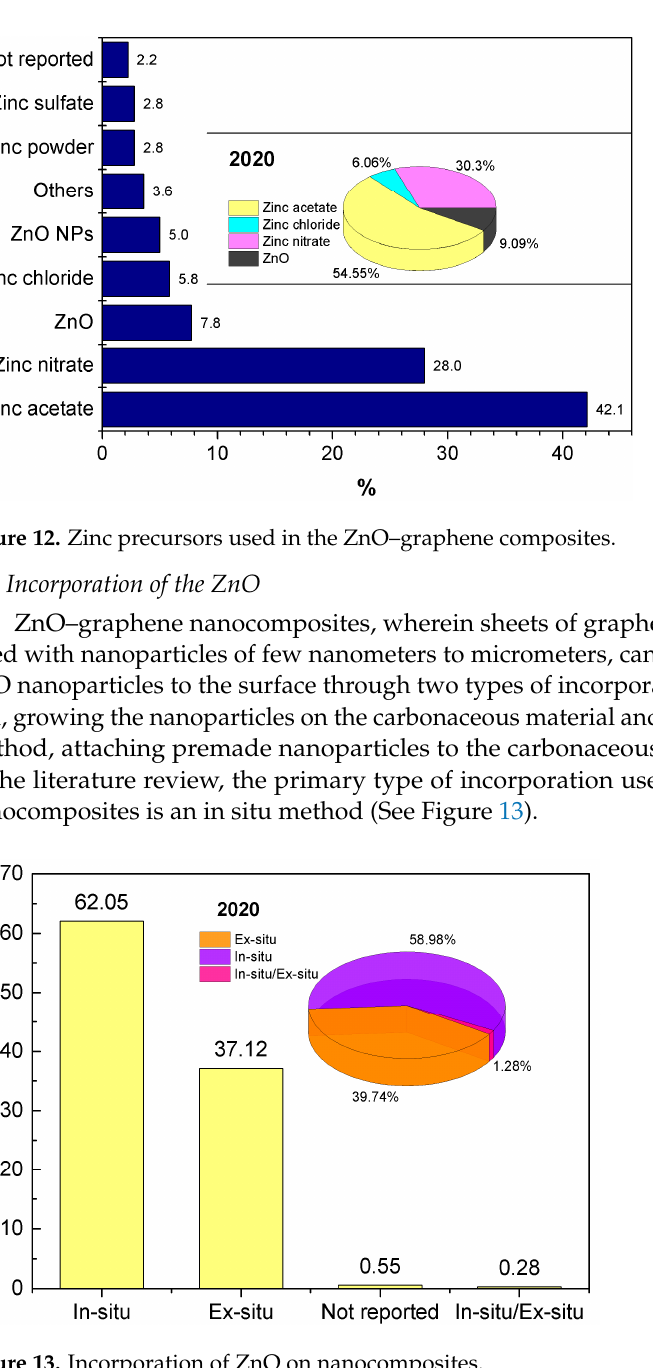
Figure 11. Type of carbonaceous support most used for ZnO–graphene nanocomposites.